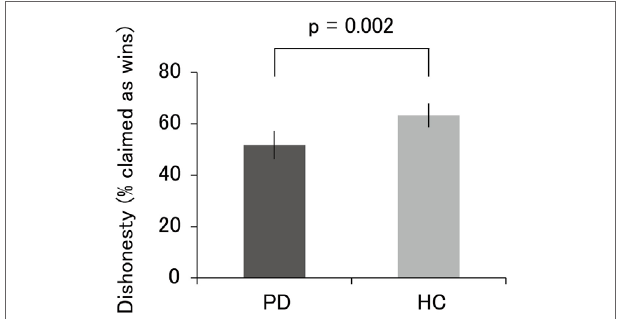
figUre 2 | Percentage of self-reported wins in PD patients and HC. The accuracy of PD patients, which did not significantly differ from the chance level of 50%, was lower than that of HC. Error bars represent 95% confidence intervals. Abbreviations: PD, Parkinson’s disease; HC, healthy controls.